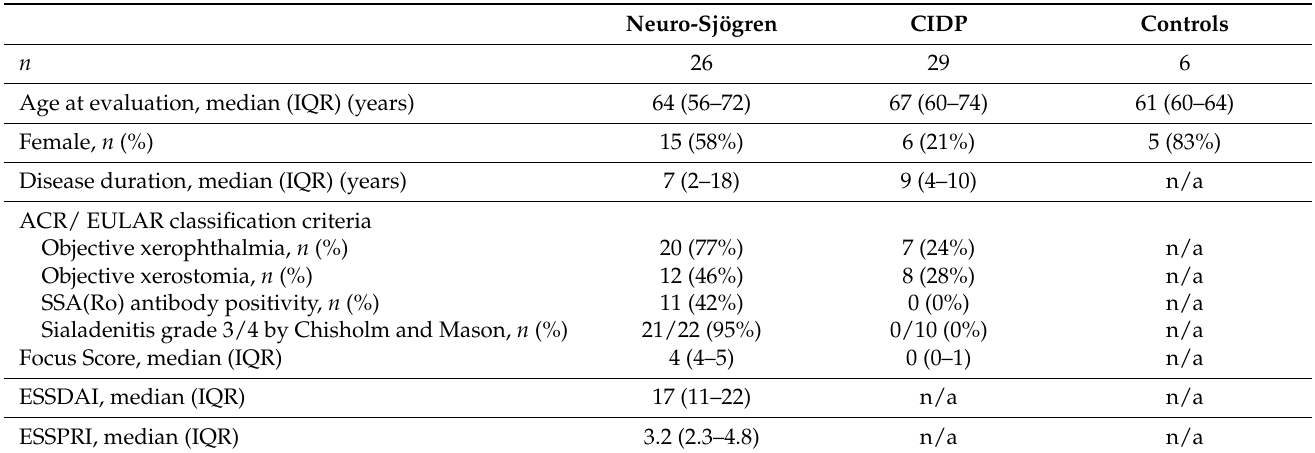
Table 2. Baseline parameters for the analyzed subgroups: Neuro-Sjögren, chronic inflammatory demyelinating polyneuropathy (CIDP) and controls.